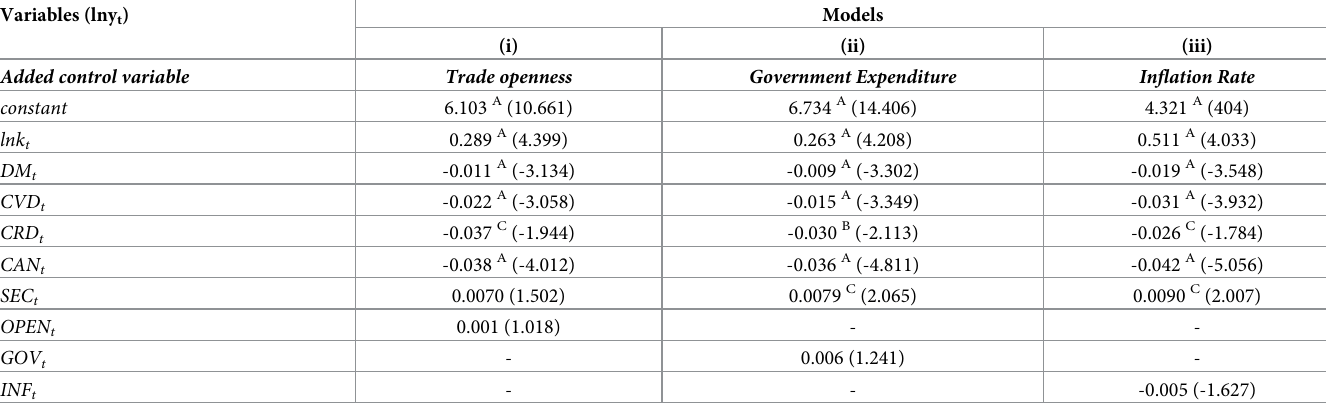
Table 9. Effect of NCD mortality on output per capita–robustness test. Variables (lny t